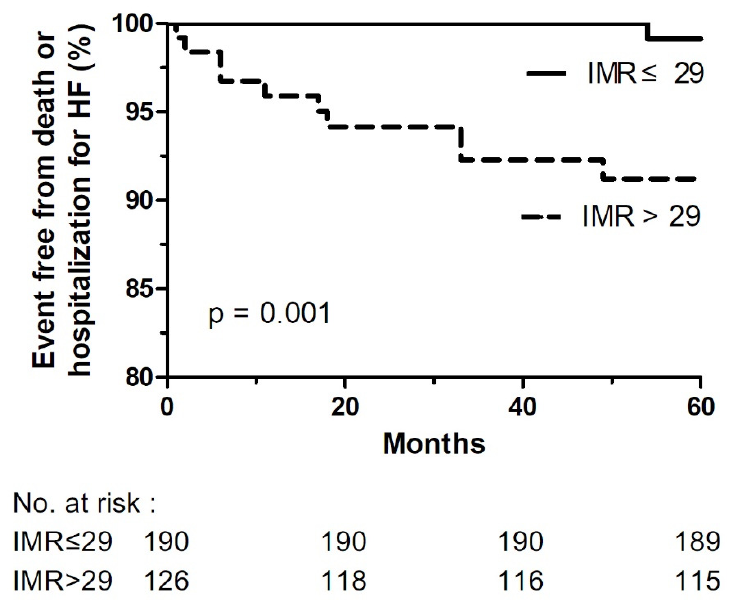
Figure 2. Kaplan-Meier curve of IMR. HF: heart failure; IMR: index of microcirculatory resistance. Table 5. Logistic regression analysis for independent predictors of death or hospitalization for HF. Univariate